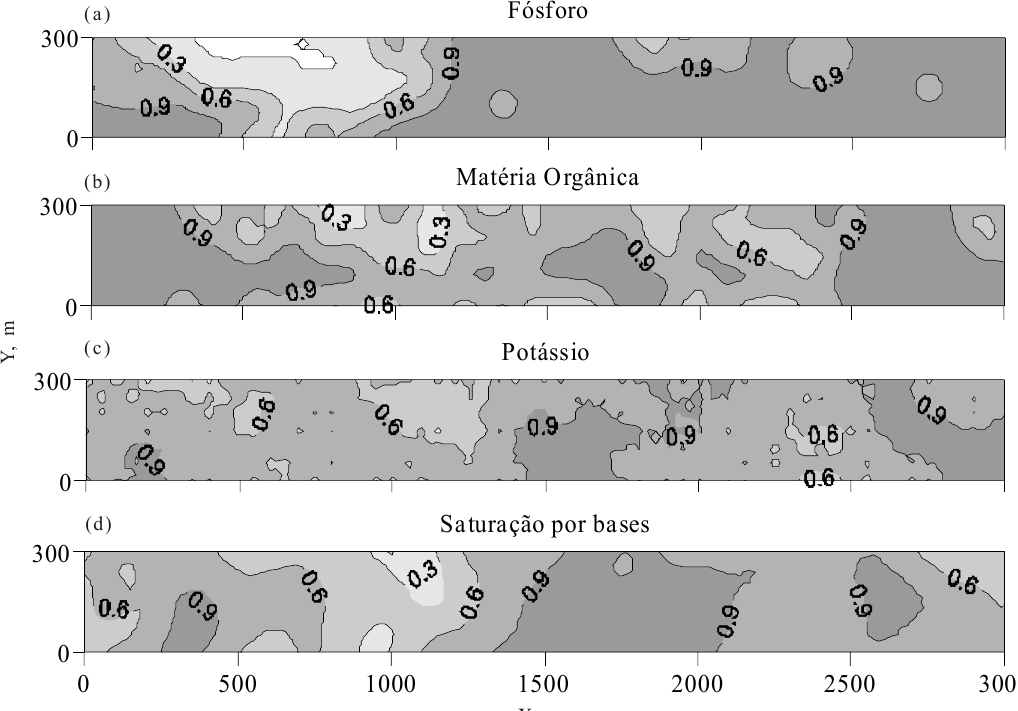
Figura 7. Mapas de probabilidade de as variáveis serem inferiores ou iguais aos valores de corte, correspondente ao seu respectivo 3 o quartil: (a) P[Z(u) ≤≤≤≤≤ 32,0]; (b) P[Z(u) ≤≤≤≤≤ 31,0]; (c) P[Z(u) ≤≤≤≤≤ 4,6]; e (d) P[Z(u) ≤≤≤≤≤